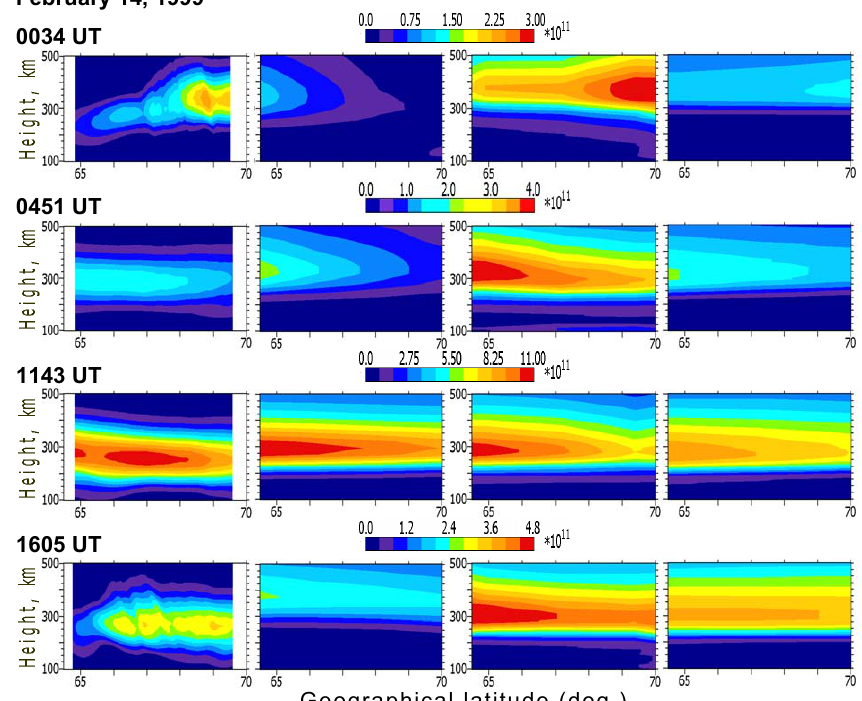
Fig. 6. Same as Fig. 3, on 14 February